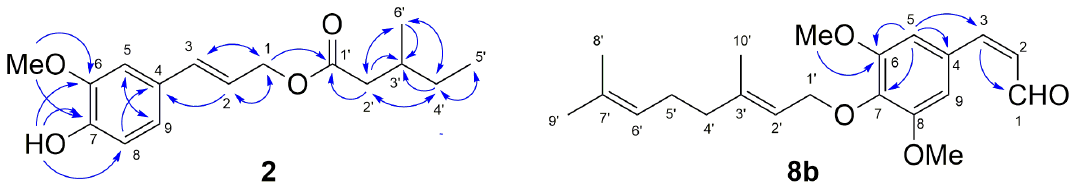
Figure 3. Selected HMBC correlations of compounds 2 and 8b .